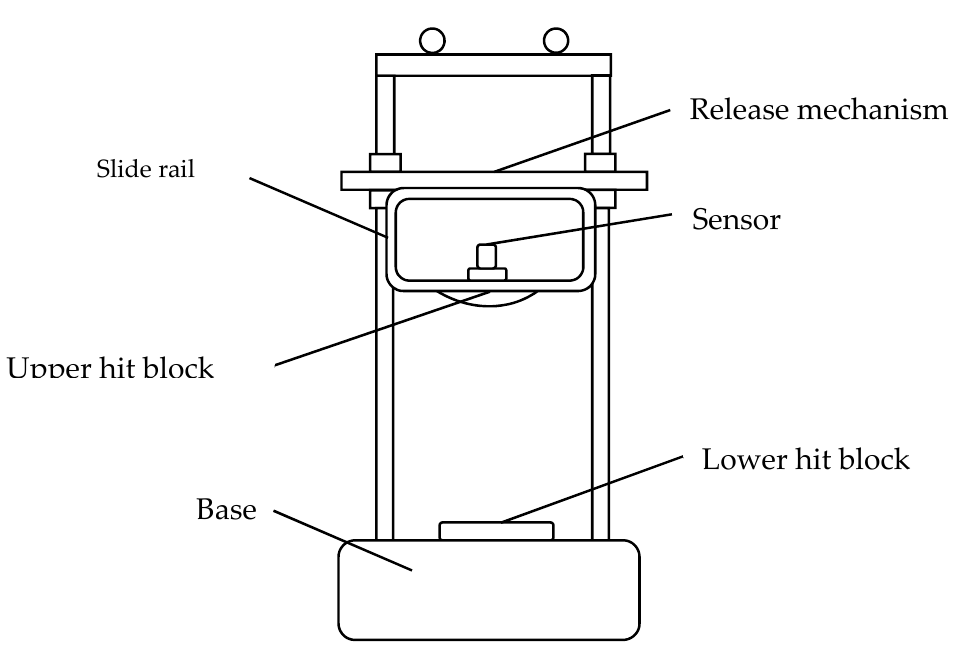
Figure 3. The schematic diagram of the test bench.